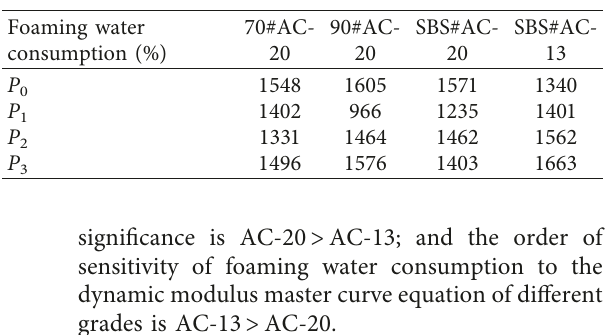
Table 7: Antipressure rebound modulus of different types of temperature mixed foam asphalt mixture.